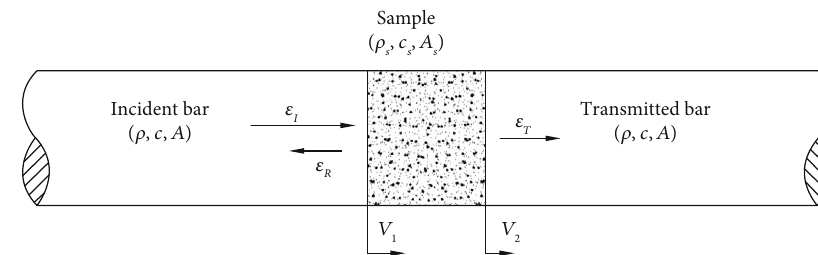
Figure 4: (a) SHPB test system and (b) the oscilloscope.